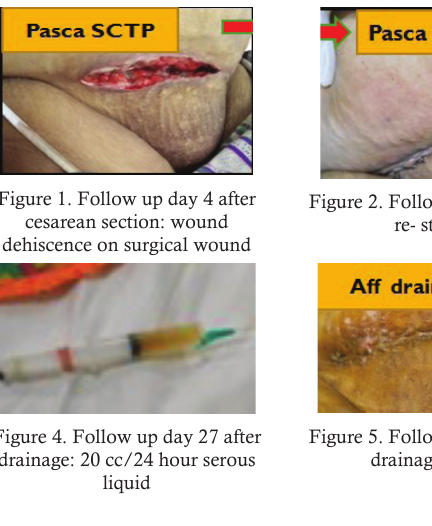
Figure 5. Follow up day 31 after drainage